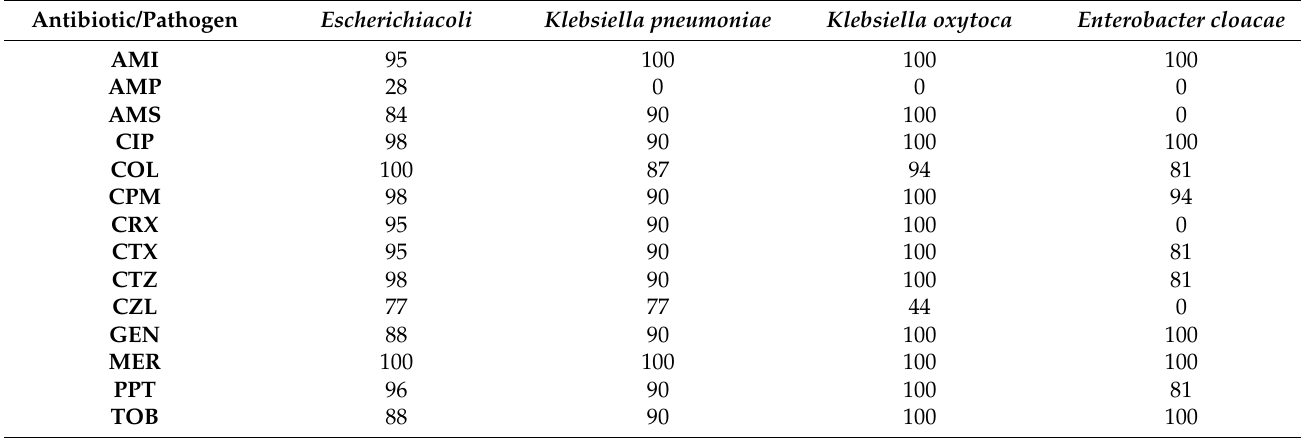
Table 5. Susceptibility of enterobacteria to selected antibiotics (percentages).